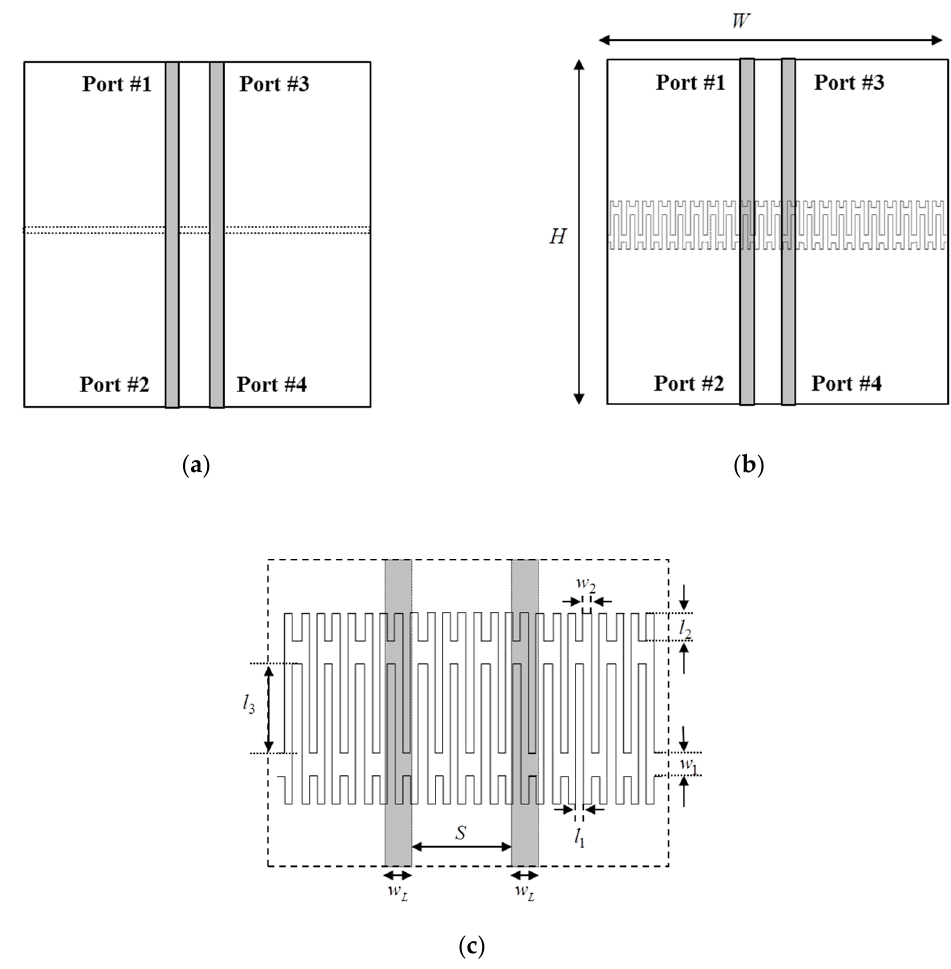
Figure 1. Printed circuit boards with two kinds of split gap adopted. The dotted line is on the bottom side. ( a ) Two signal lines cross over a straight split gap on the ground plane. ( b ) A meander DGS split gap. ( c ) Detailed structure.